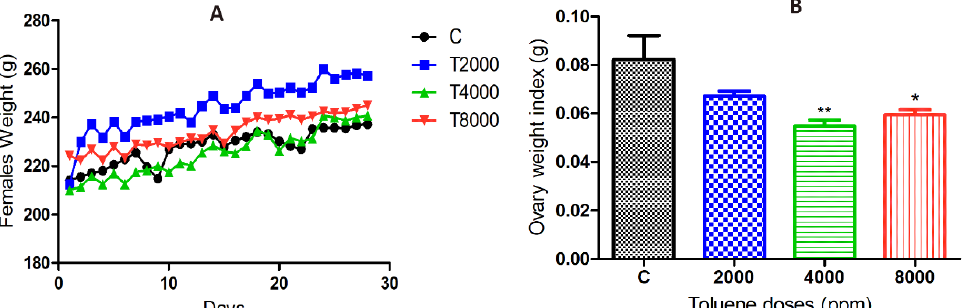
Figure 1. ( A ) Body weight changes over 28 days in the different groups exposed to toluene. ( B ) Ovarian weight changes in the toluene-exposed females compared to the control group. Values are means ± S.E.M. *, p < 0.05; **, p < 0.01.